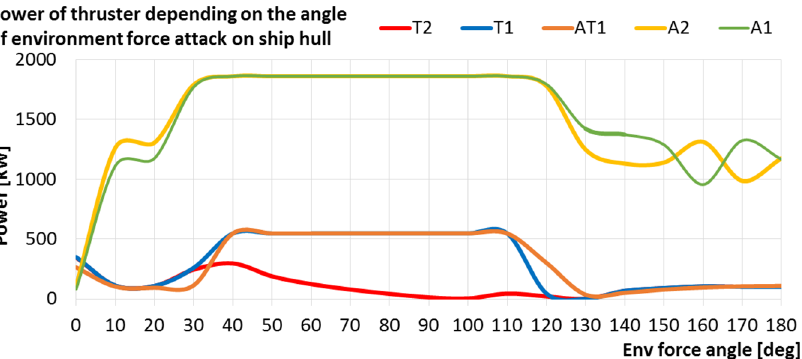
Figure 5. The power of individual thrusters depending on the angle of attack of environmental forces.